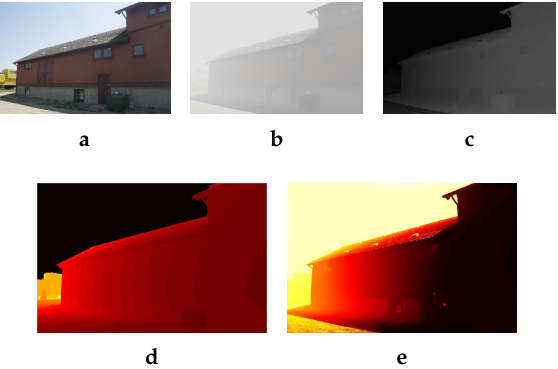
Figure 2. Optimization of the transmission: ( a ): haze-free image. ( b ): hazy image. ( c ): t b ( x ) the initialization of the transmission t ( x ) . ( d ): ground truth depth [19]. ( e ): t ( x ) the transmission. As the haze is very often nonhomogeneous, the depth information is not sufficient for dehazing. For illustration purpose, we show both the ground truth depth ( d ) and the estimated transmission ( e ). The estimated transmission should be proportional to the depth map but also reflects the density of the haze. In the transmission ( e ), the right side is less hazy and very close to the camera, so the transmission is approaching zero (dark color) and on the left side; however, the haze is denser, so the transmission approaches one (white color). The sky area in the ground truth image ( d ) is missing the depth information; it is usually considered as undefined or as infinity. This is useless in dehazing, particularly, sky dehazing which is the main contribution of this paper. Therefore, for those two reasons (nonhomogeneity and invalid depth in sky regions) the depth information cannot be introduced in Equation (3) as it is defined in Koschmieder [4] model and it needs to be considered as a haze density for real image